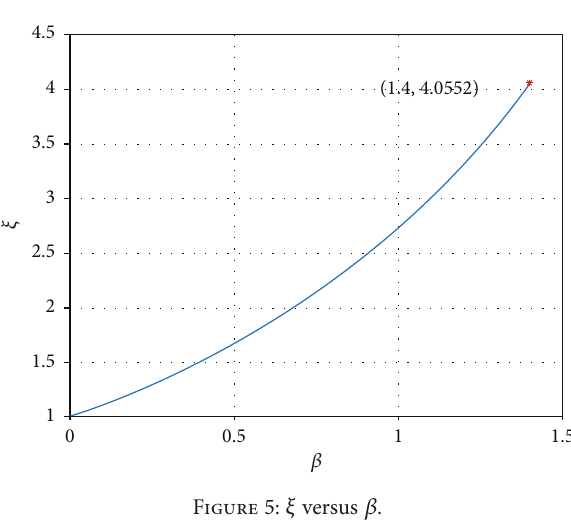
Figure 6: γ versus β .